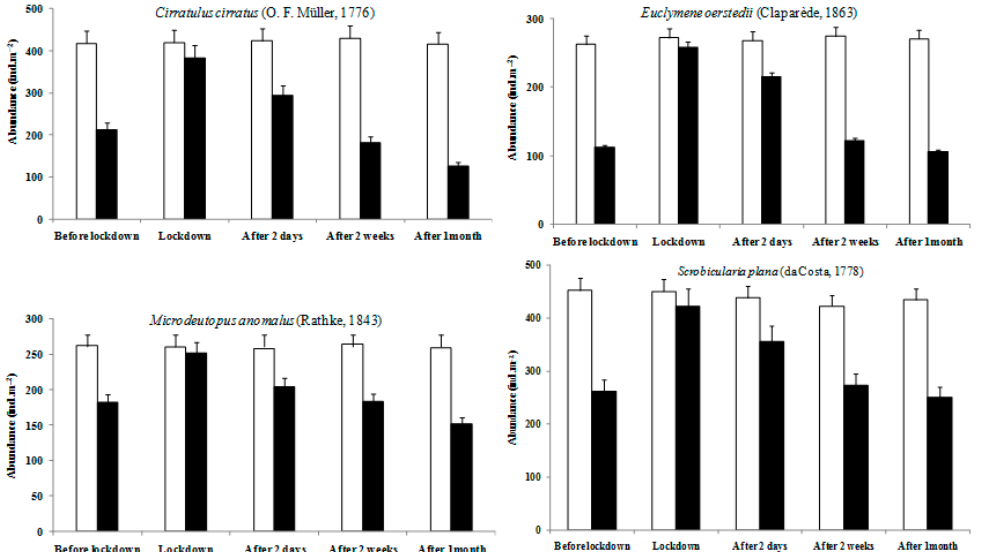
Figure 5. Mean abundance (± SD; n = 2) for some representative species at control and impact sta- tions during the five sampling periods (before lockdown; during lockdown; and after two days, two weeks, and one month of deconfinement). White column : control stations; black column: im- pacted stations.